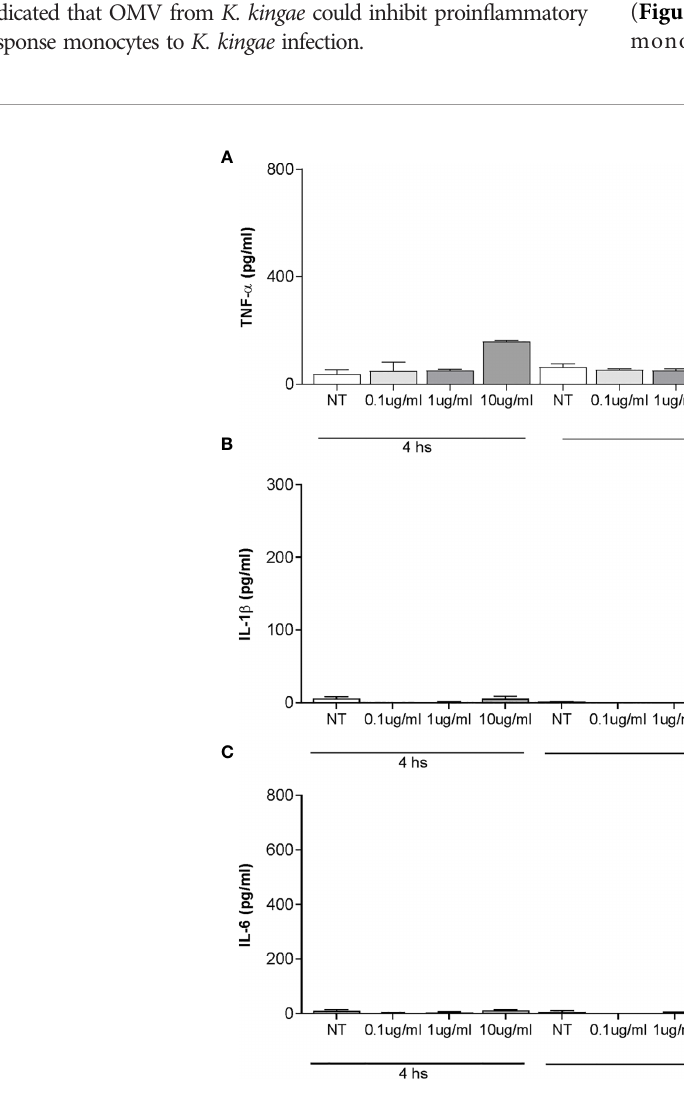
FIGURE 5 | Pretreatment with Kingella kingae outer membrane vesicles (OMV) decreases the cytokine response of THP-1 cells to K. kingae infection. THP-1 cells were incubated with OMV at a concentration of 0.1, 1, and 10 µg/ml for 4 h as control cells were non-treated. Then, these cells were infected or not with K. kingae (multiplicity of infection = 1). Culture supernatants were collected at 4 h post-stimulation with OMV and at 24 h post-infection. TNF- a (A) , IL-1 b (B) , and IL-6 (C) were measured by commercial ELISAs in the mentioned culture supernatants. The graphics are showing values obtained from three independent experiments. Data are given as the mean ± SD. * P < 0.05; ** P < 0.01; *** P < 0.001 versus